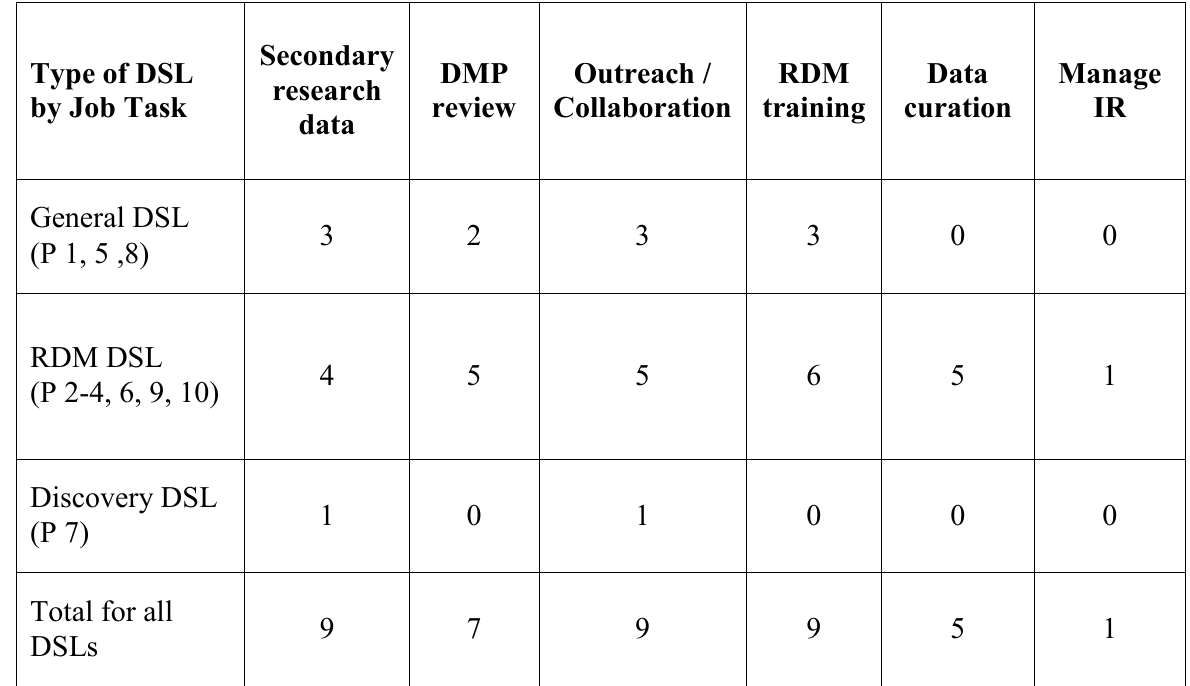
Table 2 : Types of Data Services Librarians